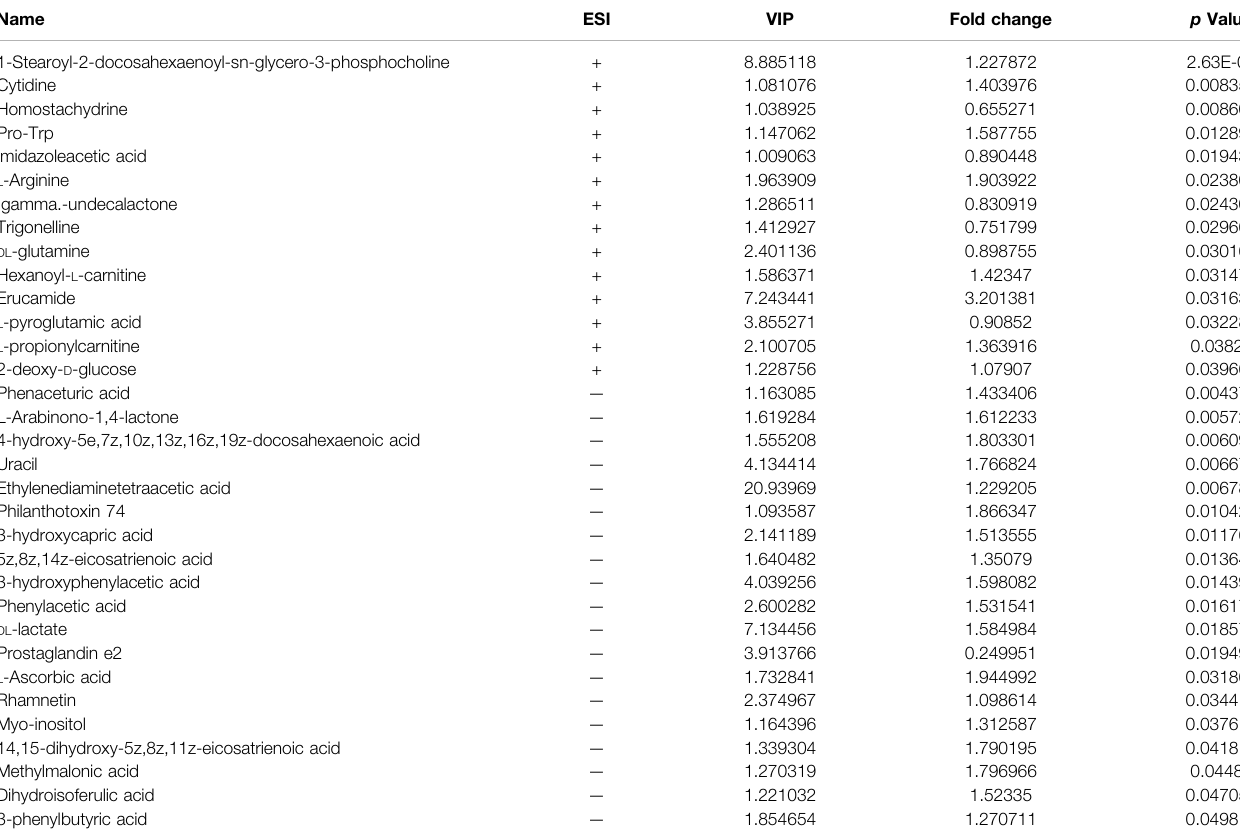
TABLE 1 | Differentiated plasma metabolites between model and TMDCT